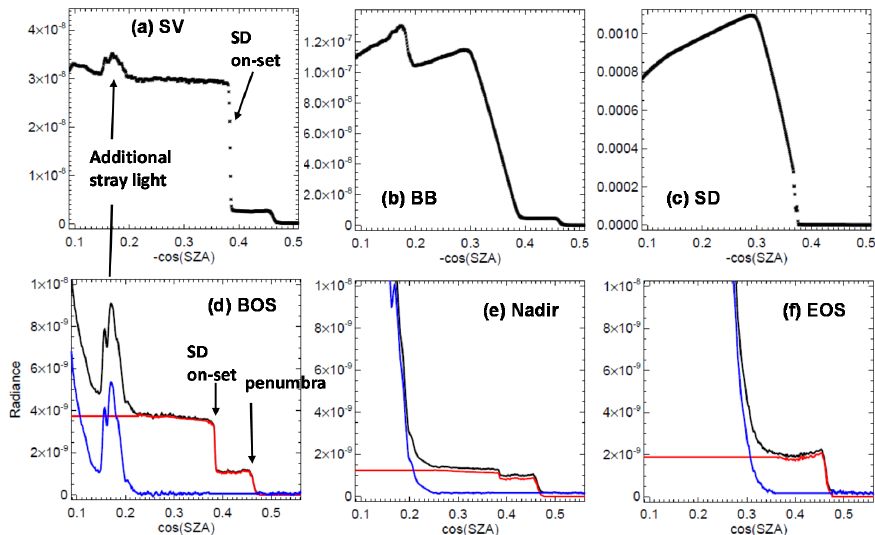
Figure 7. DNB detector 8 EV and calibration views dark signals near southern hemisphere stray light problem regions on October 5, 2013. ( a – c ) show calibration views. EV dark signals for beginning of scan (BOS), nadir, and end of scan (EOS) are shown in ( d – f ), respectively. Black curves are computed dark signals, red curves are estimated stray light, and blue curves are the signals after stray light correction. SZA = solar zenith angle. Figure 7 data is taken when additional stray light features occurred in the southern hemisphere.